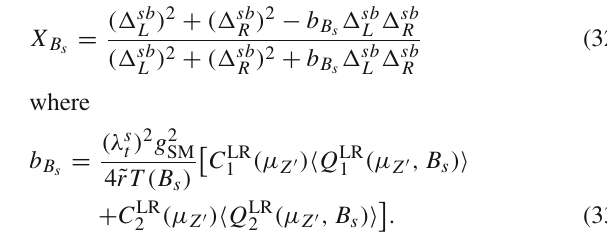
regions in the parameter space corresponding to the thin